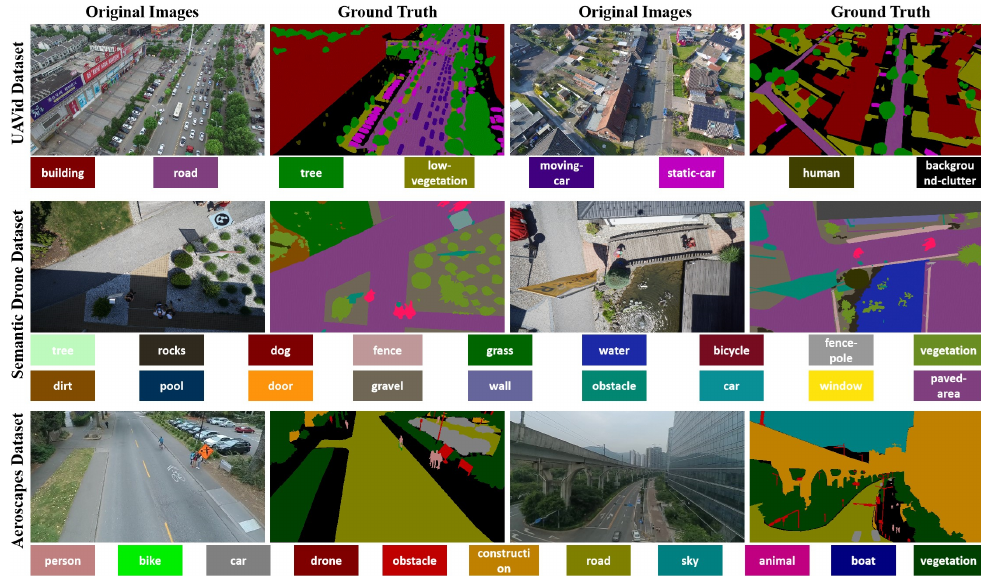
Figure 3. Example images and corresponding ground truth from the UAVid, Semantic Drone, and AeroScapes datasets. The first row shows the UAVid [2] dataset. The second row shows the Semantic Drone [70] dataset. The third row shows the AeroScapes [71]